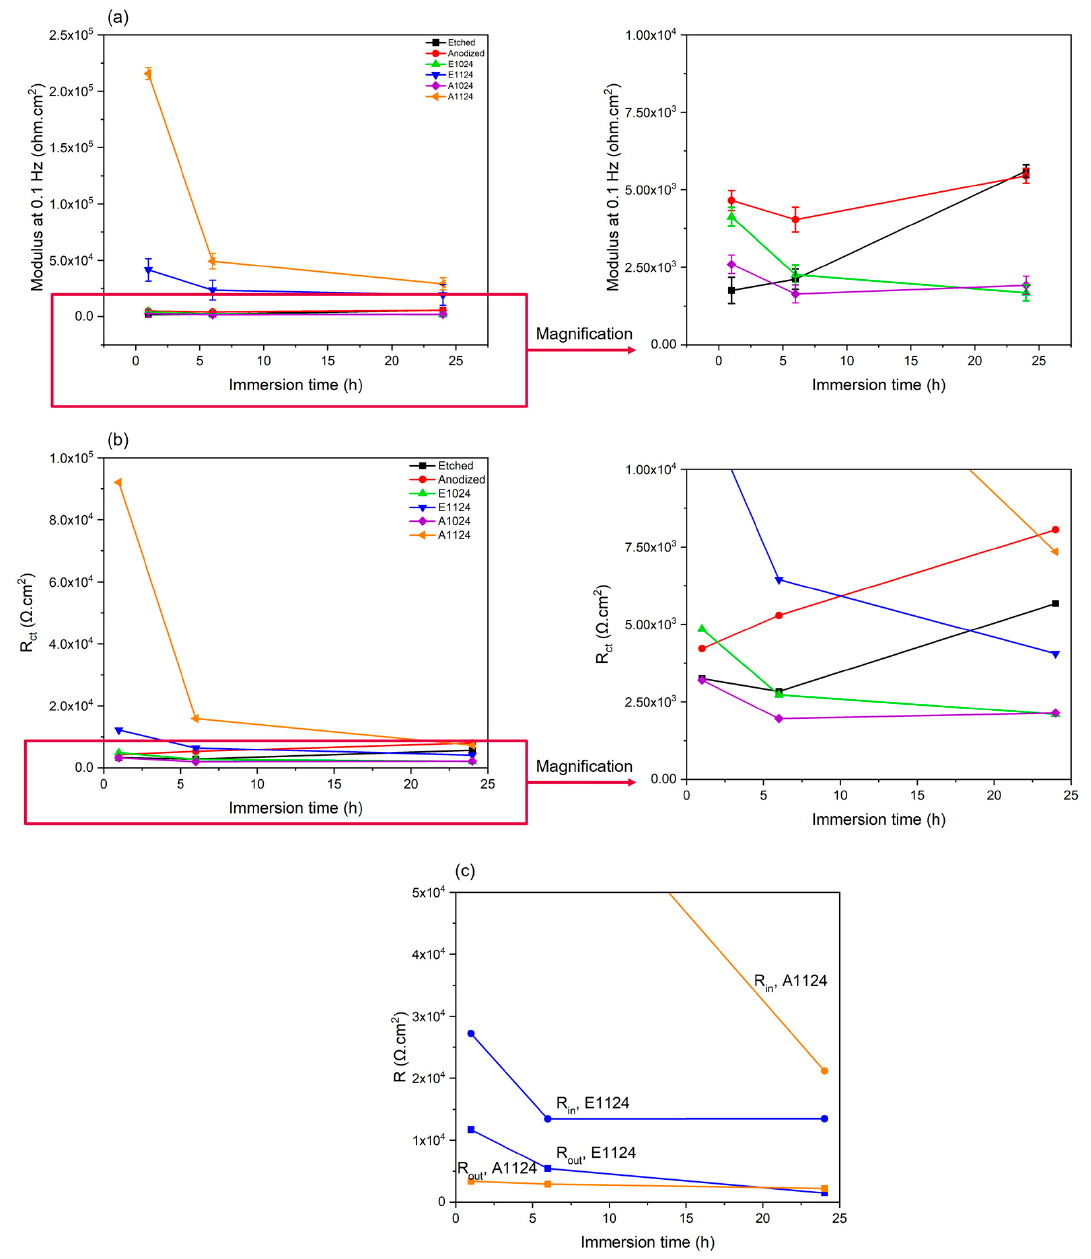
Figure 14. ( a ) Impedance modulus of samples at low frequency (0.1 Hz), ( b ) R ct , ( c ) R in and R out , with different immersion times.